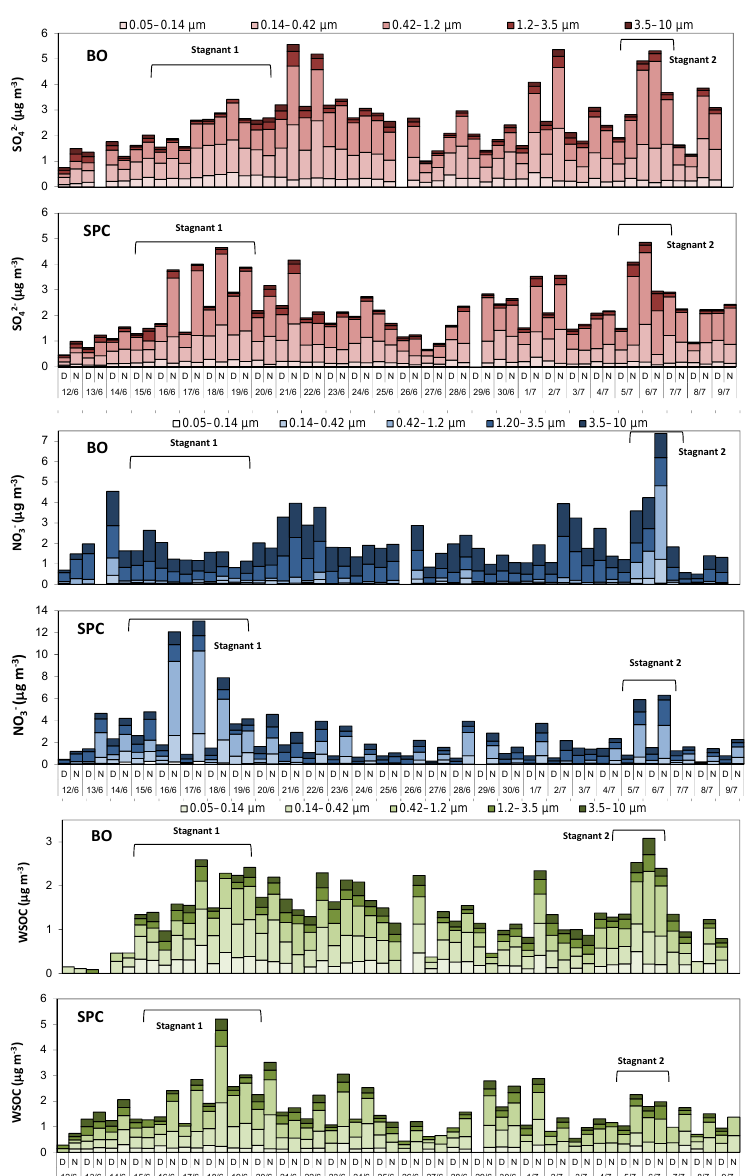
Figure 5. Time series of sulfate, nitrate and WSOC size-segregated concentrations in BO and SPC. Please note the different scale for nitrate and WSOC in